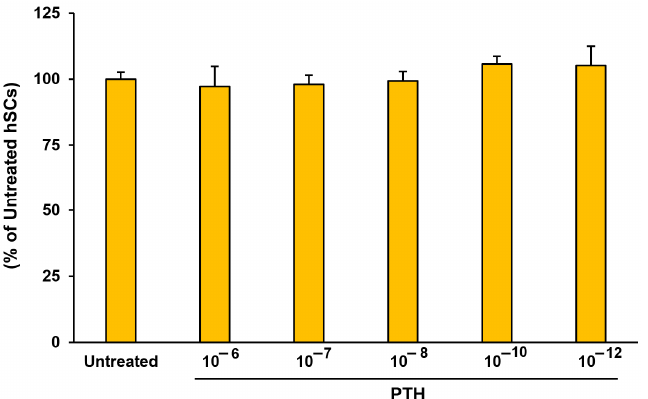
Figure 4. Effects of 30-min PTH (1-84) treatment at different concentrations on hSC proliferation process assessed by BrdU incorporation proliferation assay. The values, expressed as percentage of untreated hSCs (control), are the mean ± SD of three cells lines repeated in quadruplicate. ANOVA analysis with Bonferroni’s multiple comparison test.